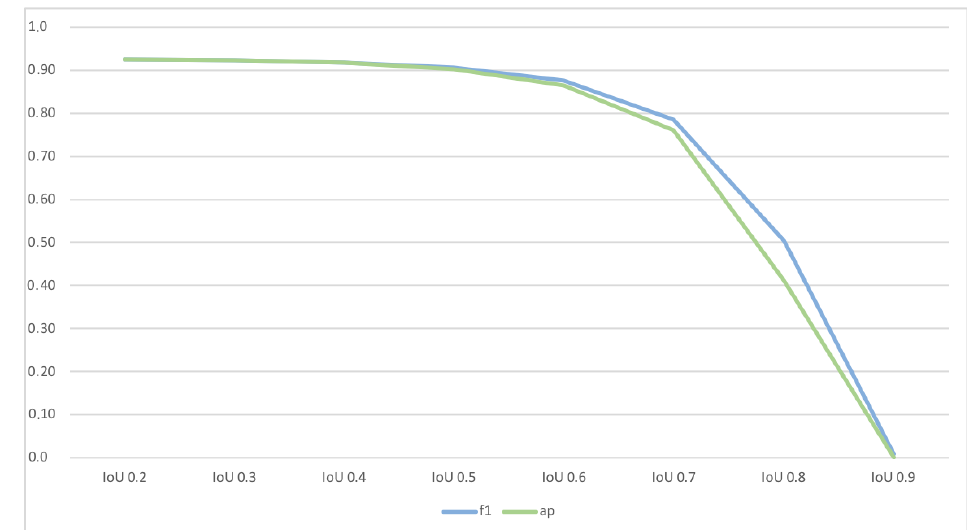
Figure 7. Classification accuracy in relation to minimal acceptable IoU—representing degree of IoU among nematode samples.